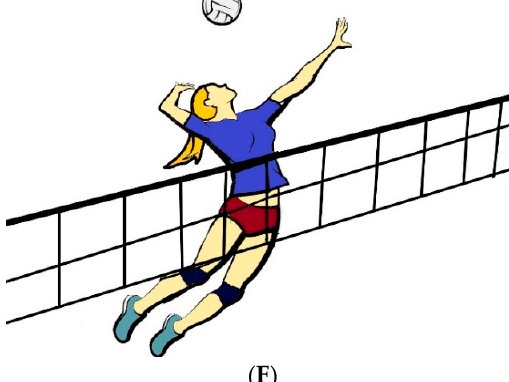
Figure 7. ( A ) Volleyball court with basic game dynamics; ( B ) The middle hitter; ( C ) The libero; ( D ) The setter; ( E , F ) The Opposite and Outside hitters.